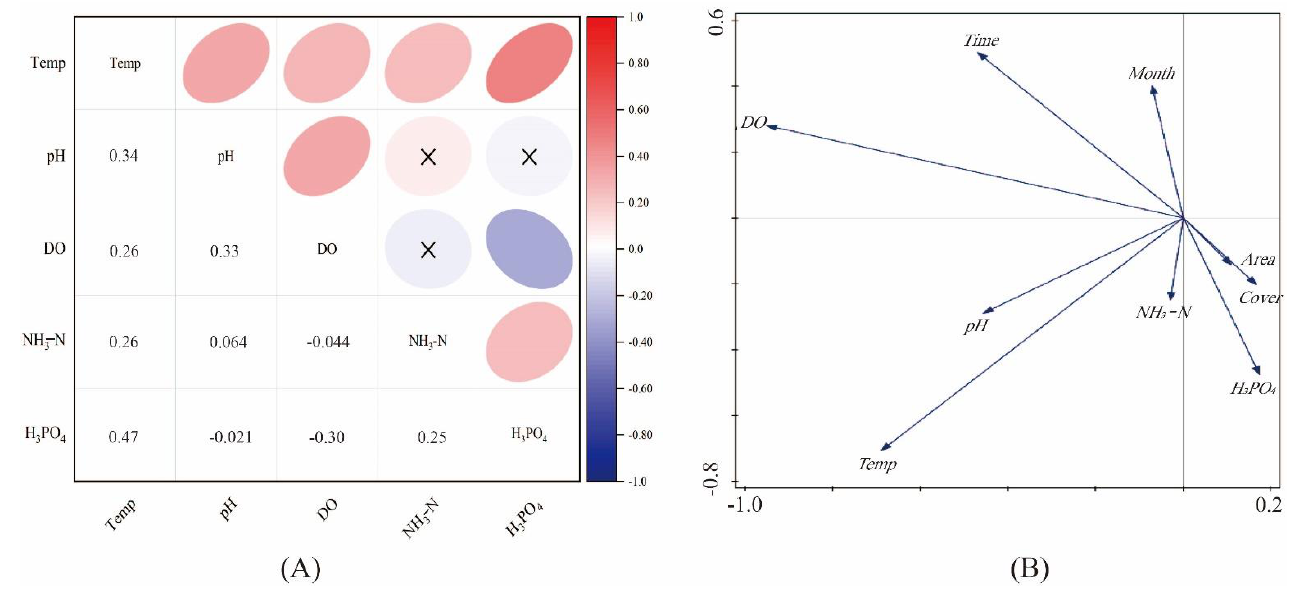
Figure 6. Correlation analysis ( A ) and principal component analysis ( B ) of environmental factors.